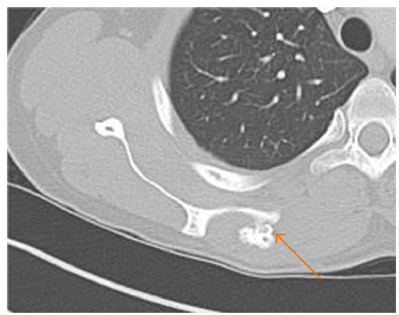
Figure 2: Thoracic CT scan axial view illustrating the solid mass measuring 2.6 cm T × 2.6cm AP × 2.2cm CC (orange arrow) at the superomedial aspect of the right